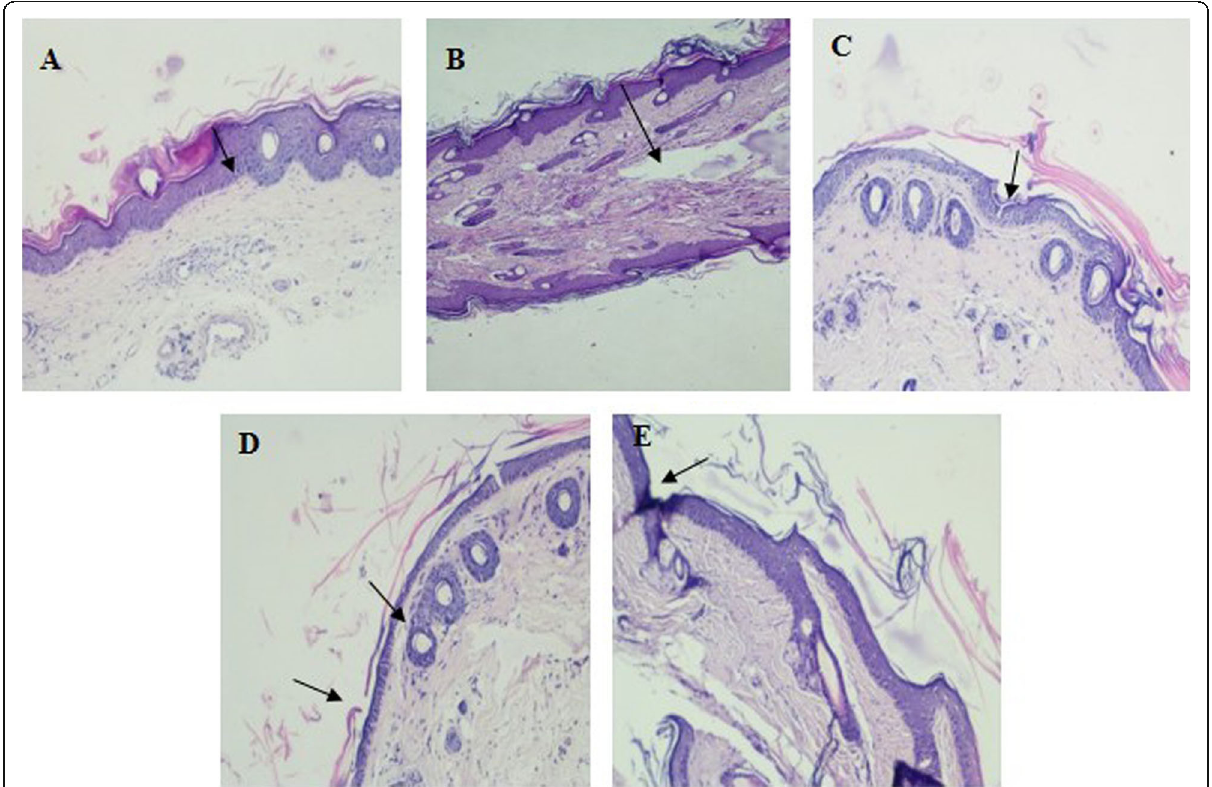
Fig. 4 Histology of the orthokeratotic mouse tail skin action: parakeratotic skin section of the mouse tail at 40x( a ) Saline ( b ) Thymoquinone ( c ) Nigella sativa Extract ( d ) TQ loaded EV gel E) Tazarotene